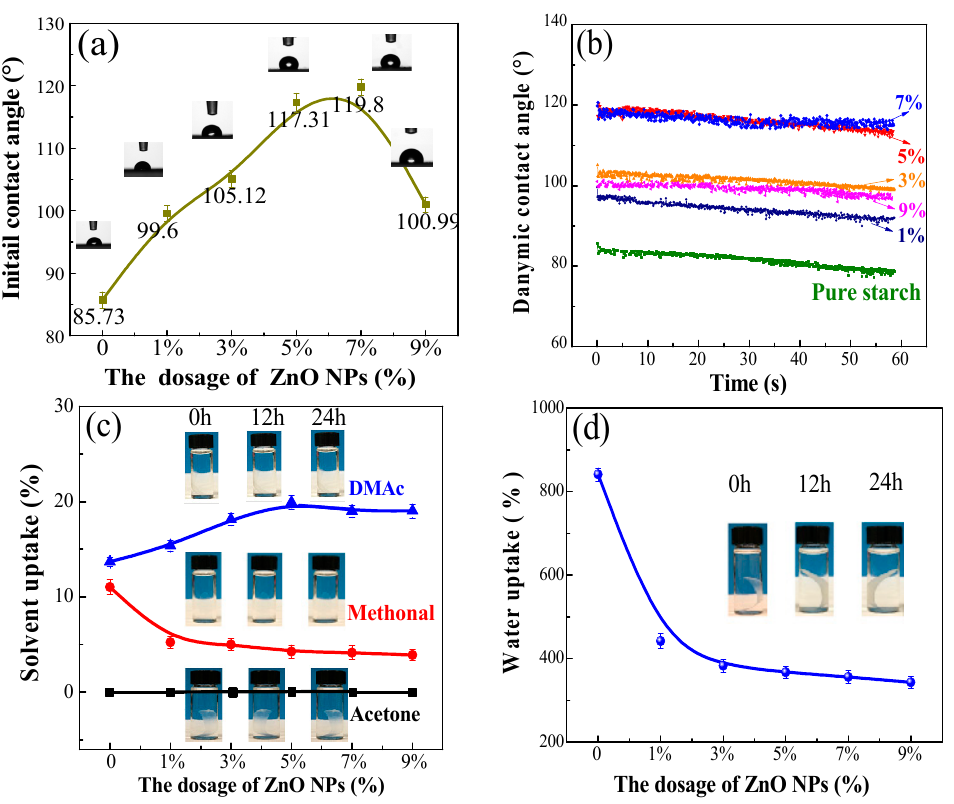
Figure 3. The water initial contact angles (ICA) ( a ) and dynamic contact angles (DCA) ( b ) of composite films loaded with various ZnO NP dosages. Solvent resistance of composite films with various ZnO NPs contents in different time periods against solvents of DMAc (triangle), methanol (circle), acetone (square) and H 2 O (ball). Organic solvent ( c ) and water ( d ) uptake of the composite films after 24 h of immersing. The ZnO dosage in the shown picture of the composite film is 5%. The error bar indicates the standard deviation.